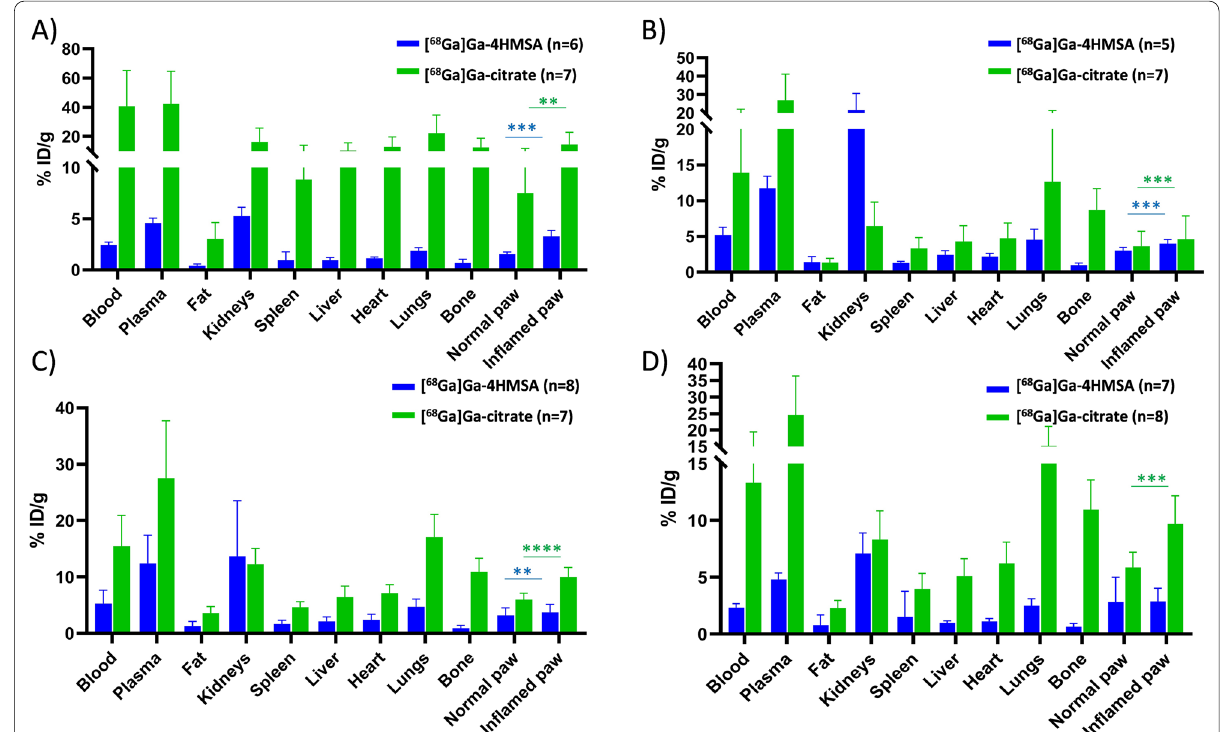
Fig. 9 Biodistribution of [ 68 Ga]Ga‑4HMSA and [ 68 Ga]Ga‑citrate in BALB/c mice injected with CFA in the footpad at days 1 ( A ), 2 ( B ), 3( C ) and 7 ( D )